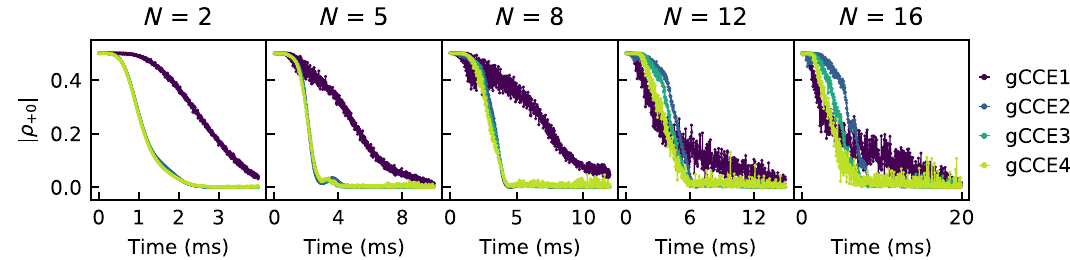
FIG. 8. Off-diagonal element of the density matrix of the qubit at zero magnetic field for various decoupling pulses N .